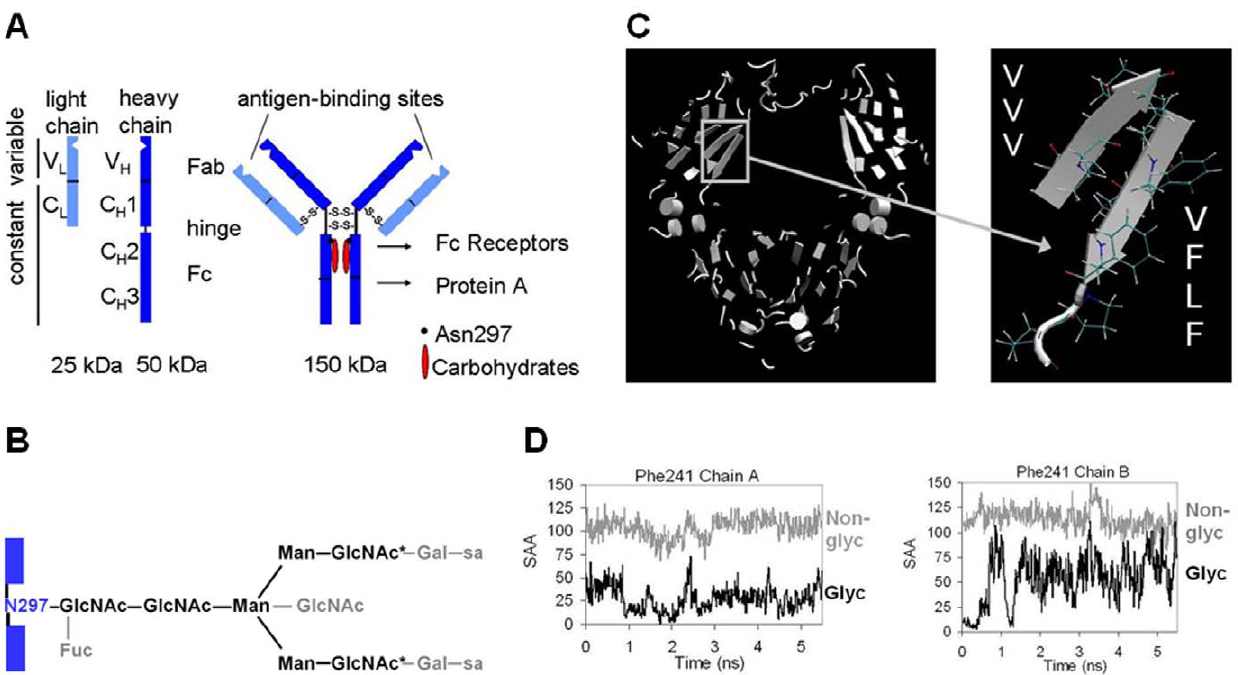
Figure 1. Computer simulations indicate dynamic fluctuations and increasing surface exposure of a hydrophobic carbohydrate- interacting residue. (A) a schematic of an IgG antibody. (B) N-linked carbohydrates at Asn297 that constitute the G0 glycosylation pattern are in black. The other heterogeneously included hexoses are in grey. (C) a view of all hydrophobic amino acids in the Fc region of IgG1 (polar and charged amino acids are excluded from this representation), and a close-up view of the most hydrophobic motif on the inner side of C H 2 that interacts with carbohydrates. (D) SAA values calculated for Phe241 on chain A (left) and chain B (right) in the antibody Fc fragment assuming presence and absence of